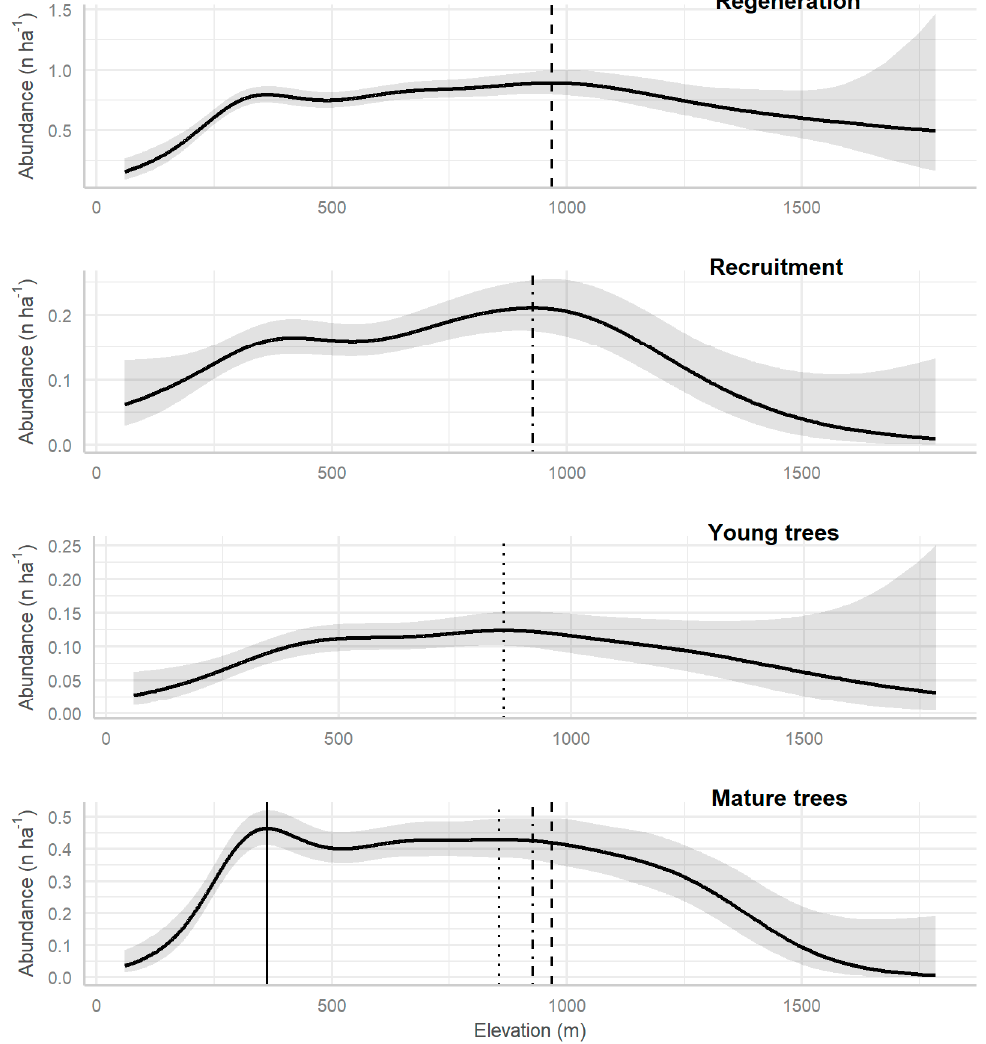
Figure 4. Predicted number of individuals per life stages of the European beech along an elevation gradient; the optimums are highlighted by vertical lines and all gathered at the bottom chart for comparison purposes.